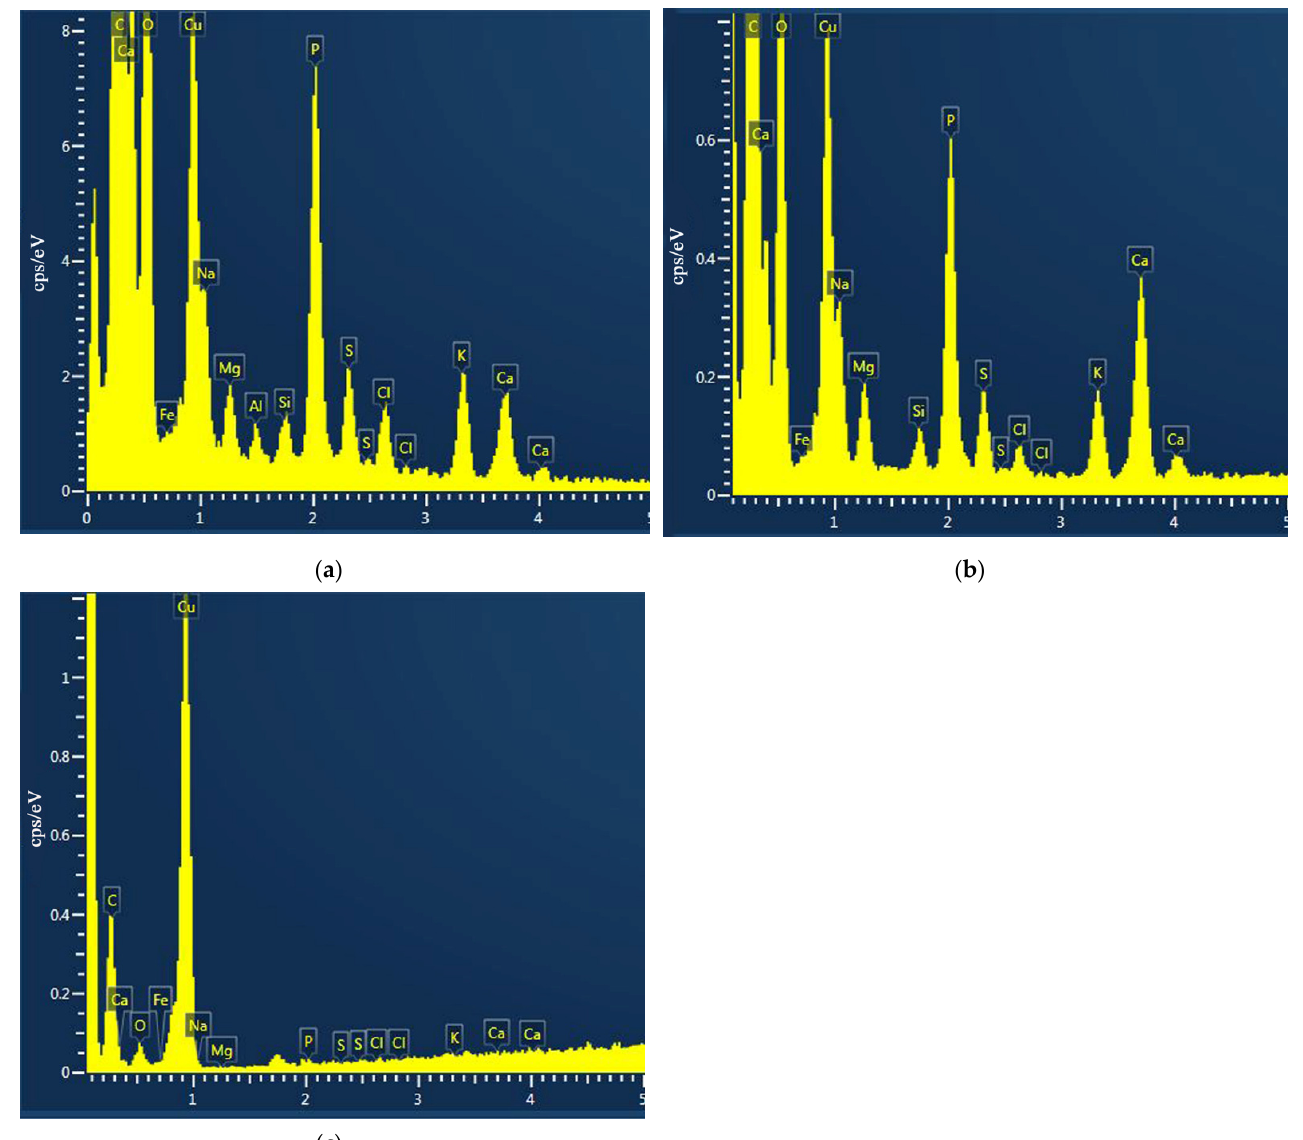
Figure 10. EDS spectrum of Escherichia coli cells: control ( a ); exposure with silver ions Ag + (1 × 10 − 5 mol L − 1 ) ( b ); exposure with Ag-Ag 2 O-NPs (1 × 10 − 5 mol L − 1 ) ( c ).